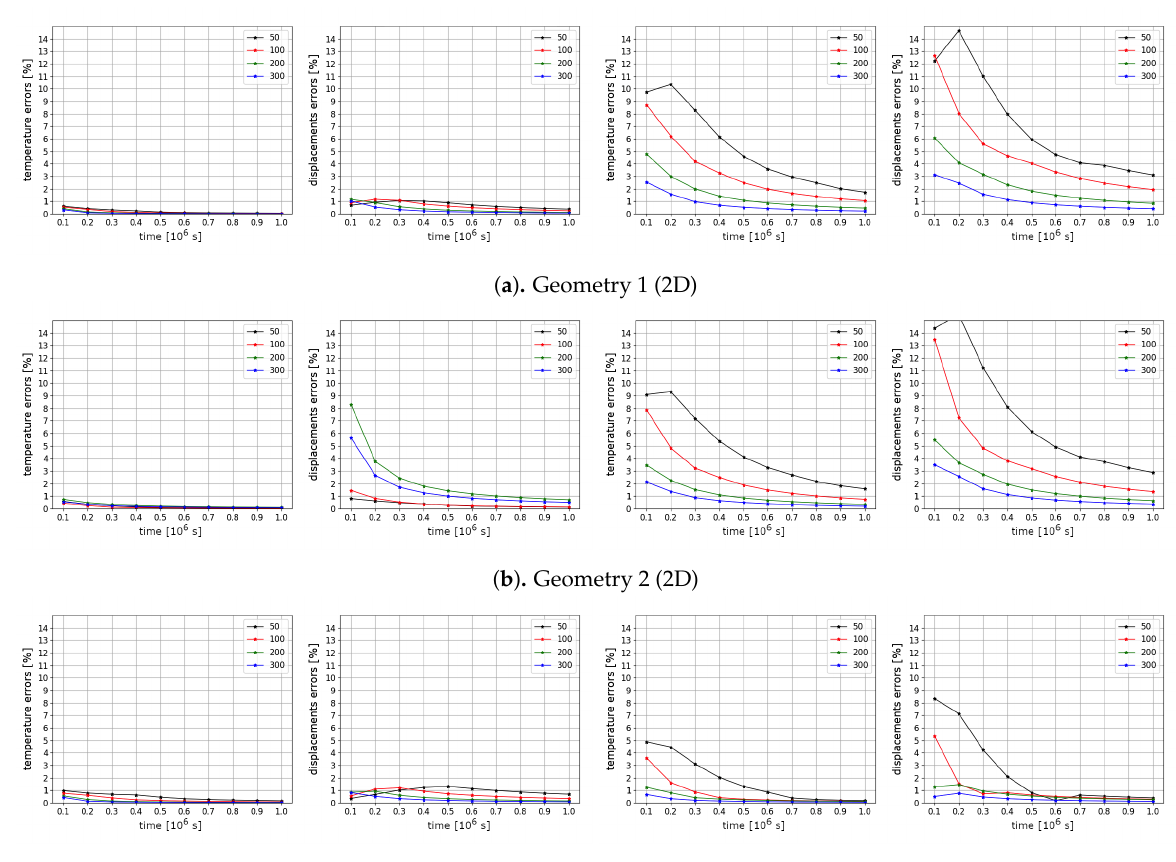
Figure 10. Results for the different number of time steps. Relative errors in % between a solution with linearization from the previous time step and solution using Picard iterations. First and second columns: temperature and displacements errors for Test 1. Third and fourth columns: temperature and displacements errors for Test